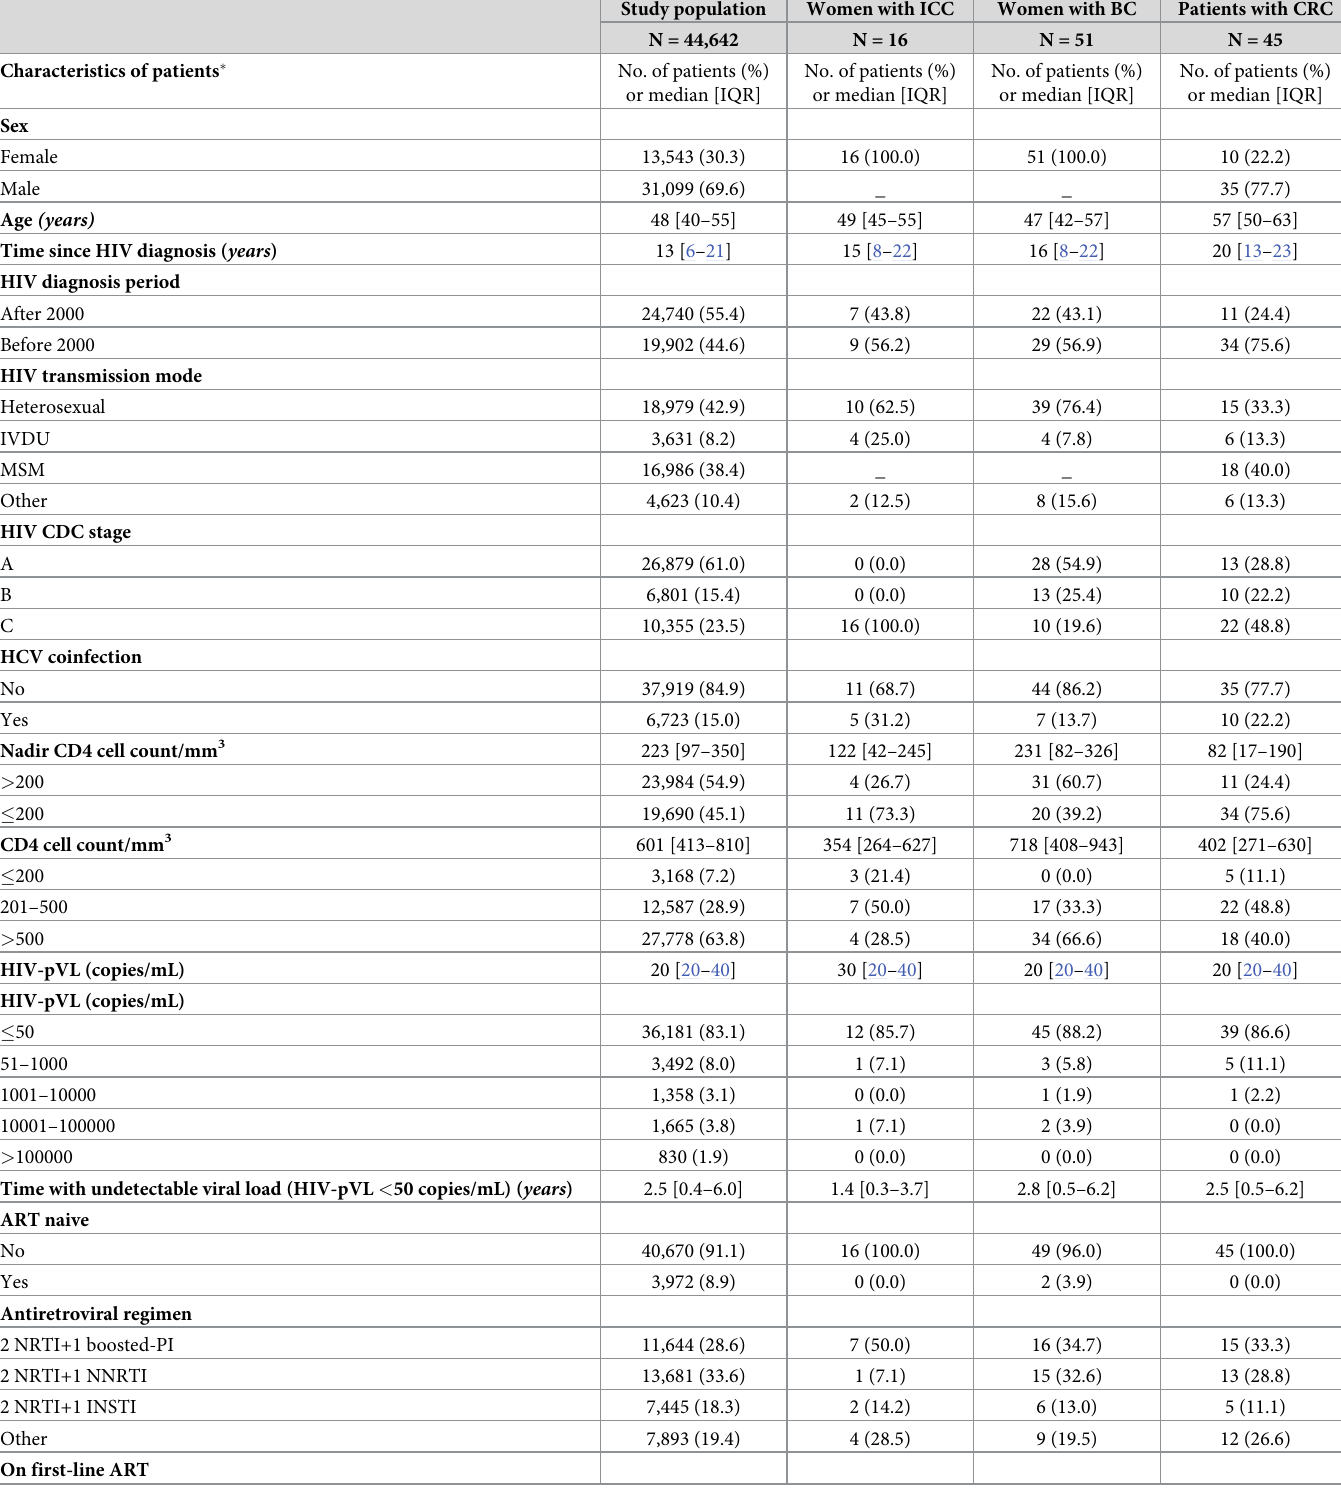
Study population Women with ICC Women with BC Patients with CRC N = 44,642 N = 16 N = 51 N = 45